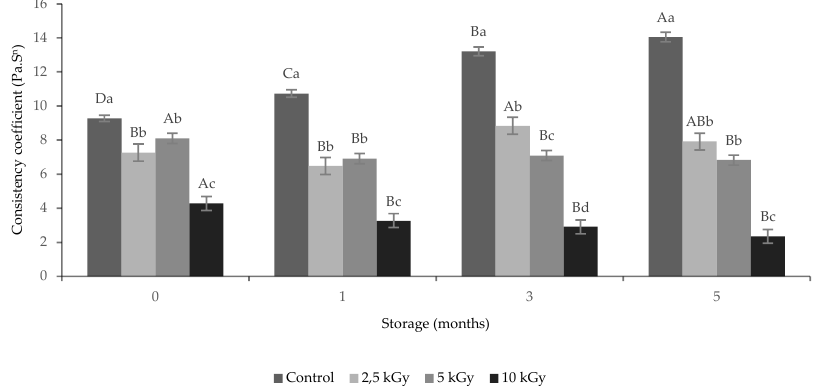
Figure 3. The consistency coe ffi cient of soups prepared with using irradiated and control tarhana samples. Capital letters represent the p < 0.05 level of statistical di ff erence between the storage